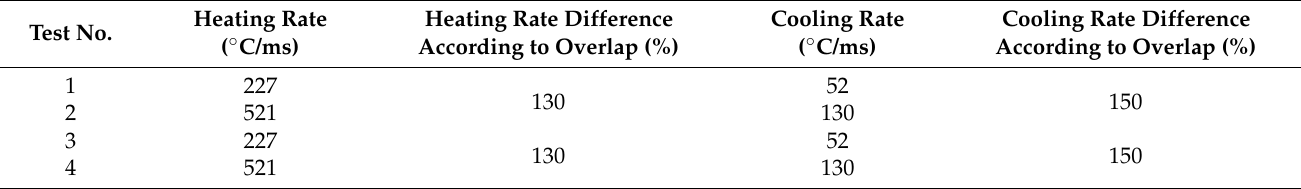
Table 4. Heating and cooling rate comparison (calculated with the first peaks in the graphs in Figure 5). Test